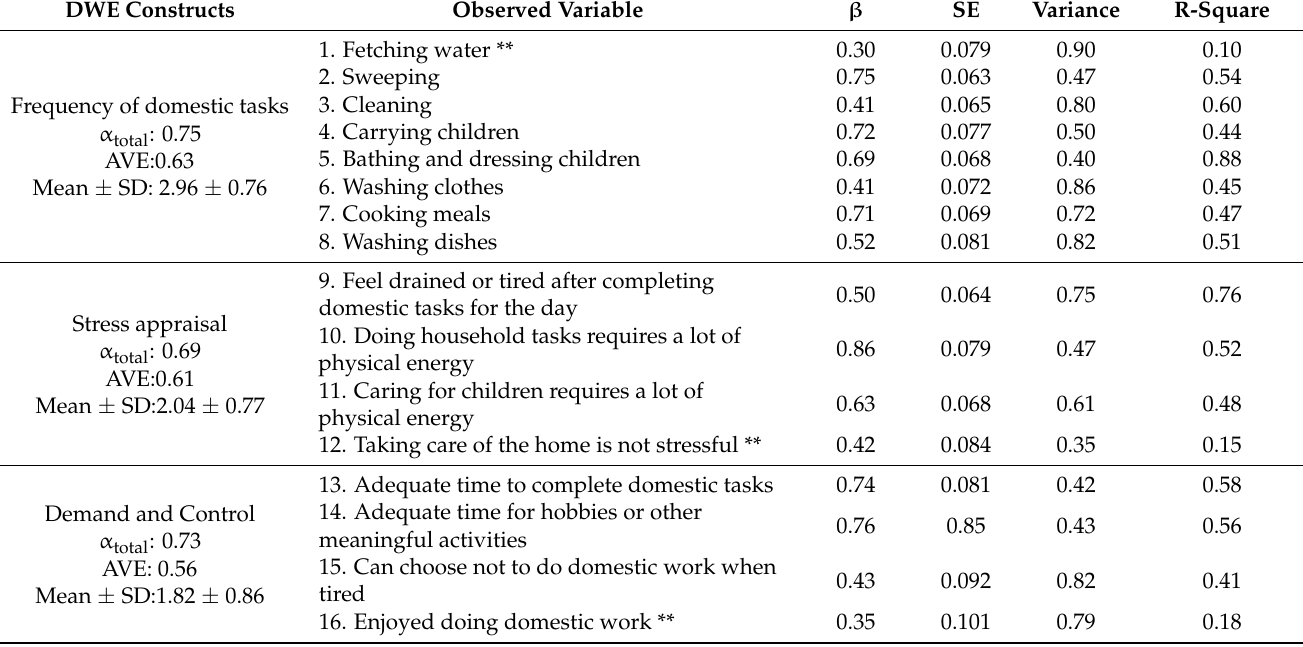
Table 1. Parameter estimates and factor loadings from confirmatory factor analysis, Model